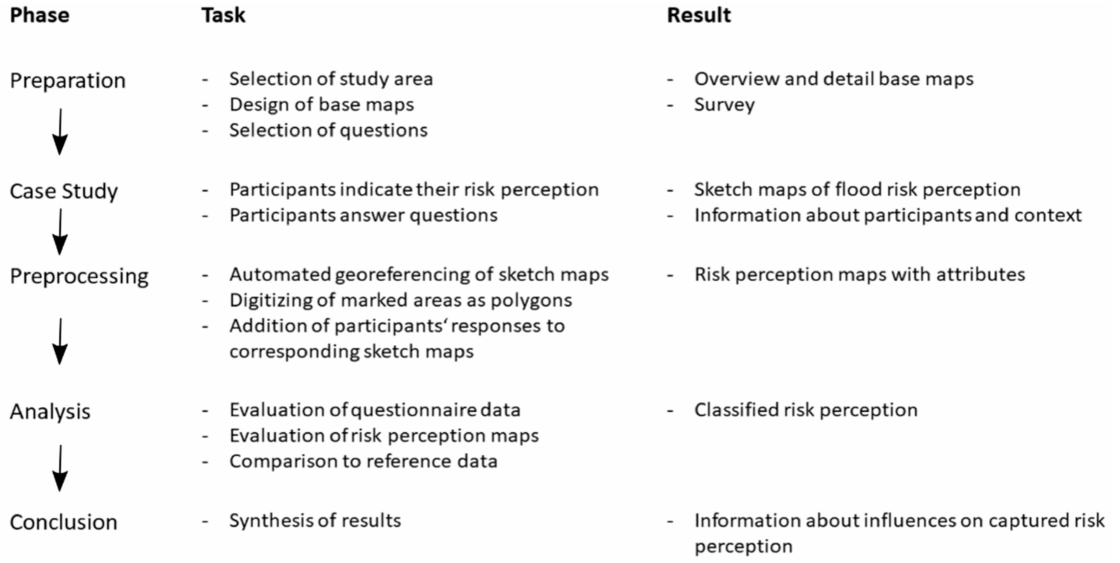
Figure 1. Workflow showing the different tasks and results of each of the steps of the research. After the design of the case study and the conduction of the field work, the preprocessing of the collected data takes place. These data are analyzed in detail and conclusions are